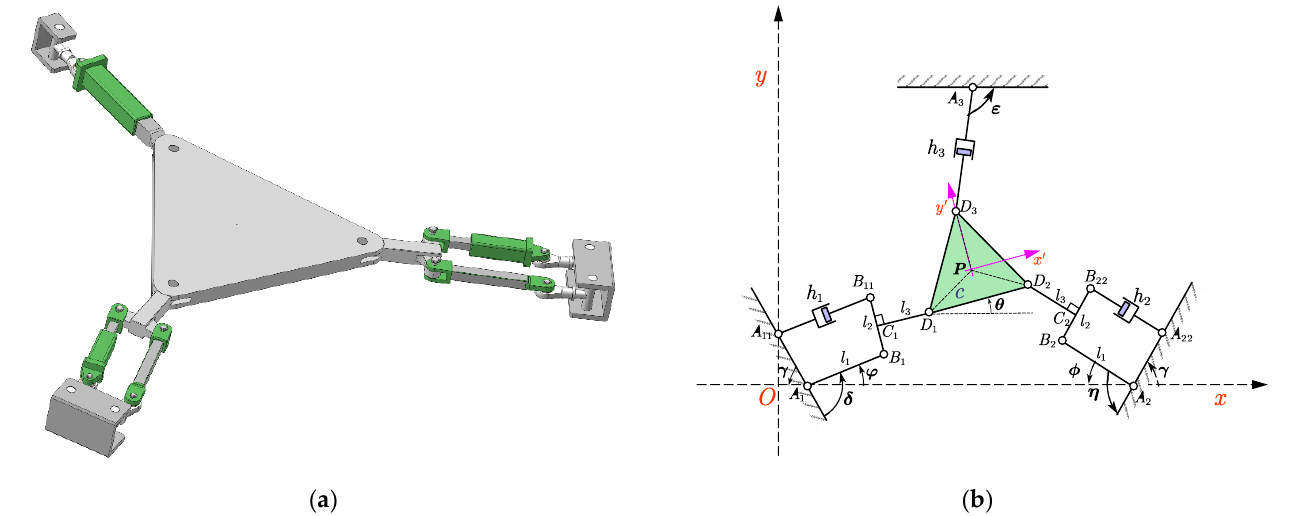
Figure 2. A 2T1R-type parallel mechanism ( a ) three-dimensional physical model. ( b ) Simplified diagram of the mechanism.